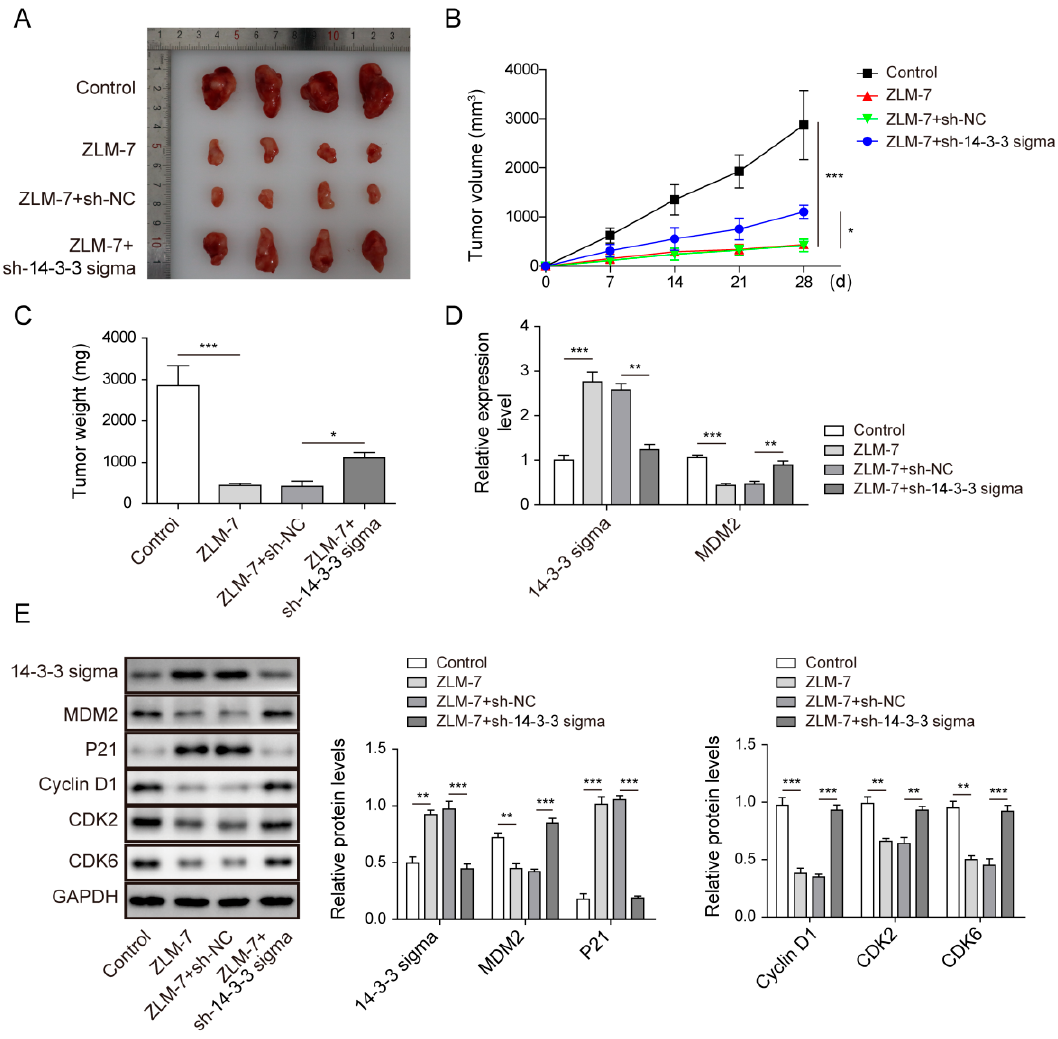
Figure 7. ZLM-7 suppressed tumor growth via regulating 14-3-3 sigma/MDM2 axis in vivo. Mice were inoculated subcutaneously with breast cancer cells or cells transfected with either sh-14-3-3 sigma or sh-NC. ( A ) Xenografts harvested from the animals; ( B , C ) Tumor volume and weight with ZLM-7 treatment for 28 days. ( D ) Relative gene expressions of 14-3-3 sigma and MDM2 in xenografts measured by qPCR. ( E ) Relative protein levels of 14-3-3 sigma, MDM2 and cell-cycle regulatory proteins in xenografts detected by Western blotting. * p < 0.05, ** p < 0.01, *** p < 0.001.